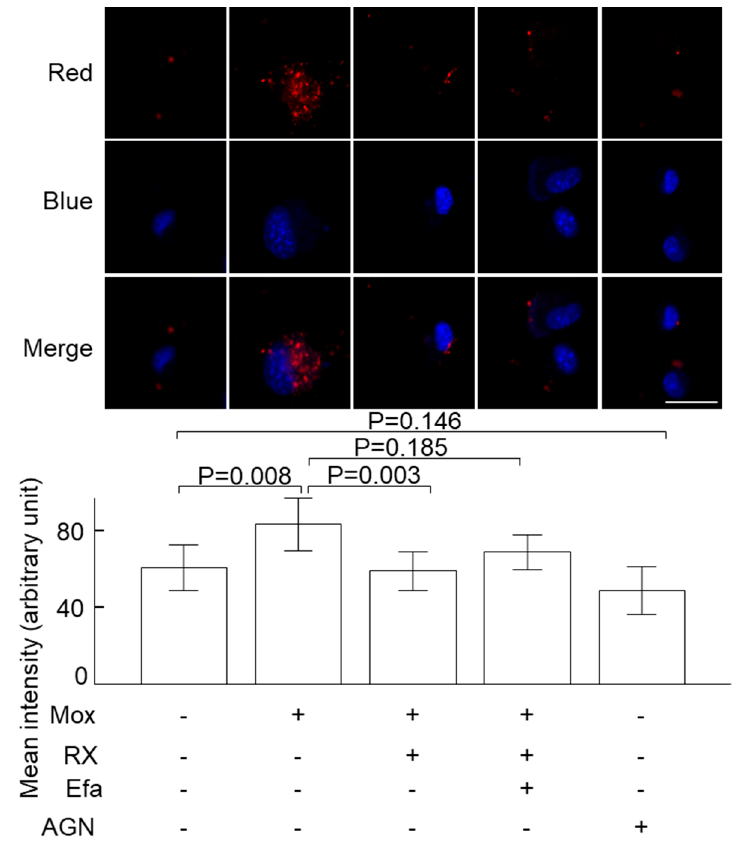
Figure 2. The effect of moxonidine on oxidised LDL uptake by VSMCs. VSMCs were incubated with RX821002 (10 µM, α 2 adrenoceptor inhibitor), efaroxan (10 µM, α 2 adrenoceptor and I1 receptor inhibitor) or AGN192403 (100 µM, I1 receptor activator) for 30 min and moxonidine (10 µM) or phosphate-buffered saline (PBS, control) was then added to the cells. After another 2 h, Dil-labelled oxidised LDL (25 µg/L) was added to all the cells and the red fluorescence (engulfed Dil-labelled oxidised LDL) inside of each cell was visualised by a confocal microscope after 4 h. The mean fluorescence intensity of the cells in the dish was calculated using ImageJ. The differences among groups were analysed using Kruskal–Wallis one-way ANOVA followed by Bonferroni’s post hoc tests. Data represent mean ± SD; N = 8. Scale bar = 40 µm. AGN, AGN192403; Efa, efaroxan; Mox, moxonidine; RX, RX821002.